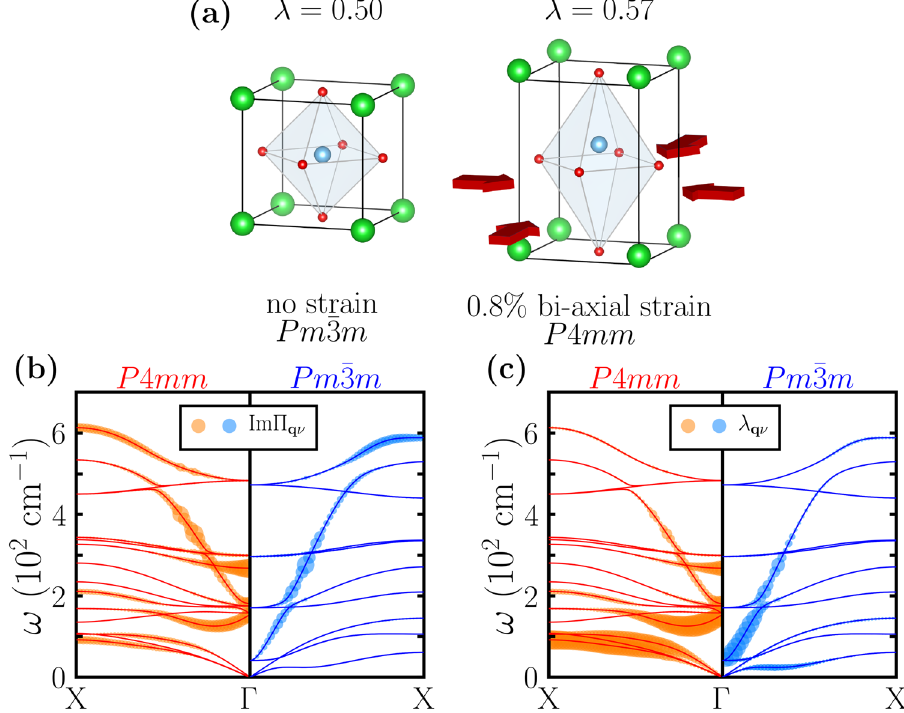
Fig. 4 Comparison of doped BaTiO 3 between the cubic structure and the strain-induced tetragonal structure. a Doped BaTiO 3 at 0.11 e /f.u. concentration. Left is the cubic crystal structure of BaTiO 3 with no strain (space group Pm (cid:1) 3 m ) and right is the polar tetragonal crystal structure of BaTiO 3 under 0.8% bi-axial strain (space group P 4 mm ). b The imaginary part of the electron-phonon self-energy Im Π q ν for each phonon mode of doped BaTiO 3 , at 0.11 e /f.u. in the P 4 mm structure (red, left) and in the Pm (cid:1) 3 m structure (blue, right). The point size is proportional to Im Π q ν . The largest point corresponds to Im Π q ν = 3.8 meV. c Mode-resolved electron-phonon coupling λ q ν for each phonon mode of doped BaTiO 3 , at 0.11 e /f.u. in the P 4 mm structure (red, left) and in the Pm (cid:1) 3 m structure (blue, right). The point size is proportional to λ q ν . The largest point corresponds to λ q ν =